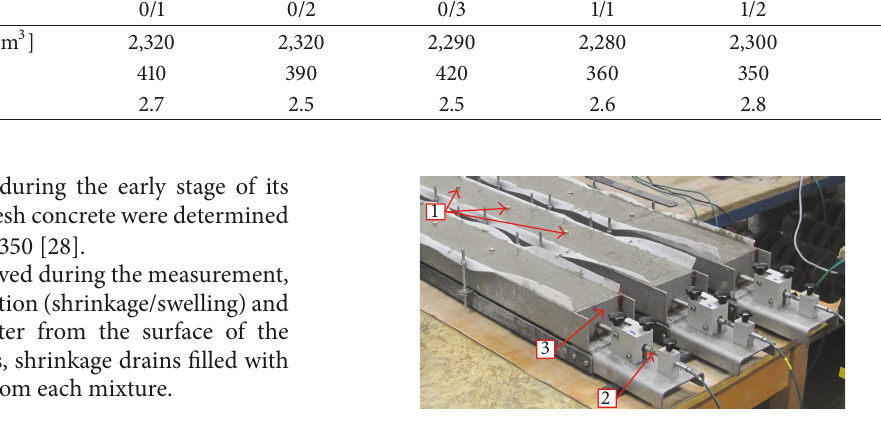
Figure 1: Shrinkage drains ready for measurement (1: embedded markers; 2: inductivity sensor; 3: movable